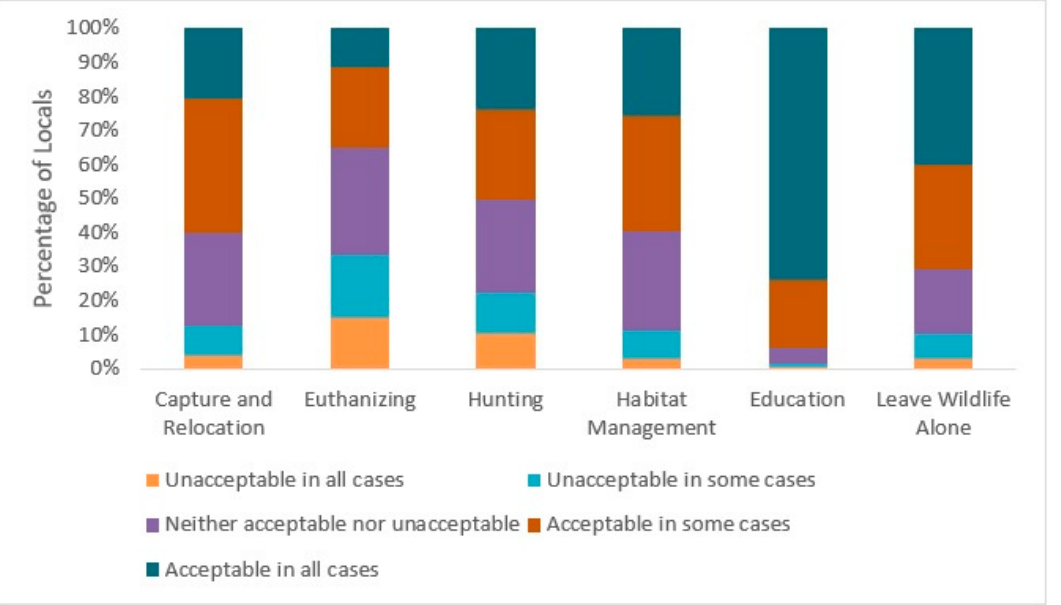
Figure 2. Locals’ acceptability of wildlife management methods in Malaysia.